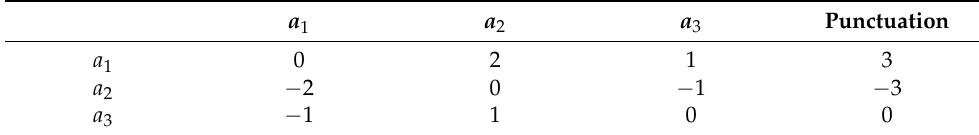
Table 3. Example of qualitative comparison